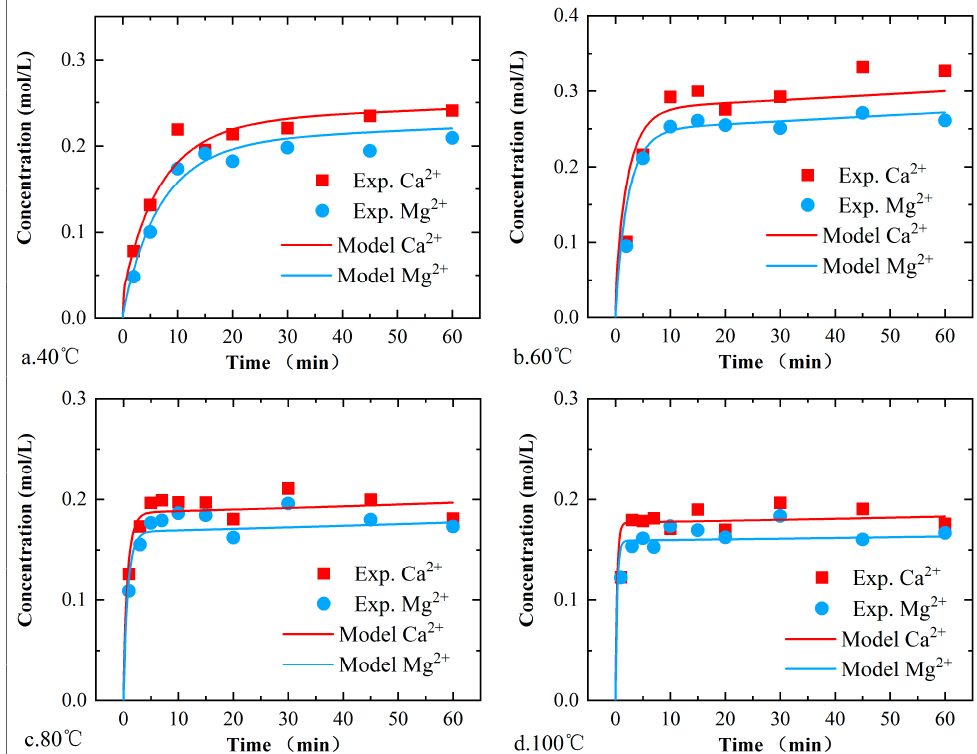
Figure 11. Comparison of Ca 2+ and Mg 2+ concentrations for R1 core.